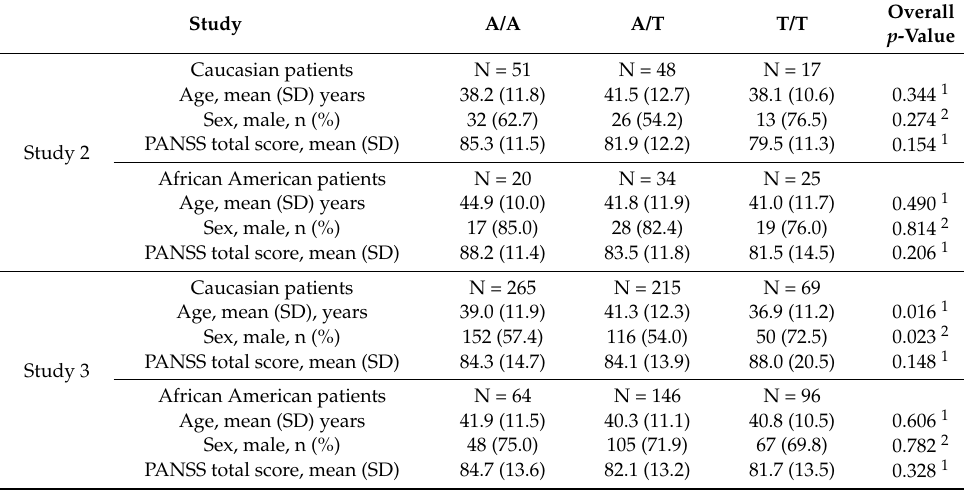
Table 2. Baseline demographics and efficacy measures across rs7330461